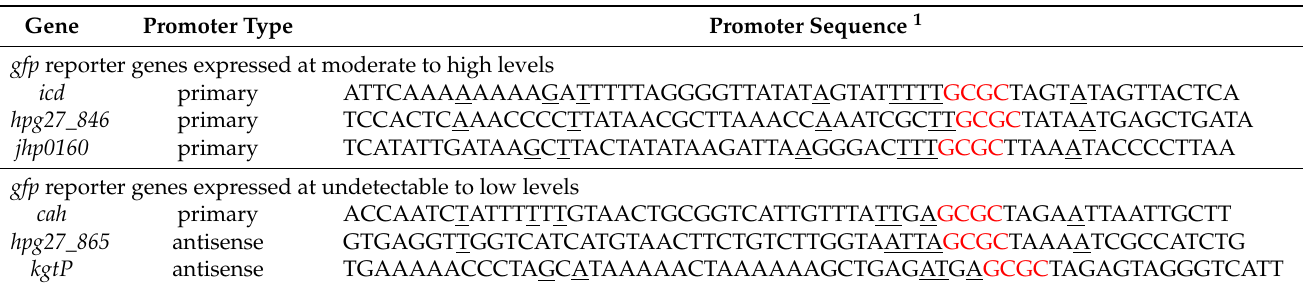
Table 1. Sequences of predicted GCGC-containing promoters examined in gfp reporter gene